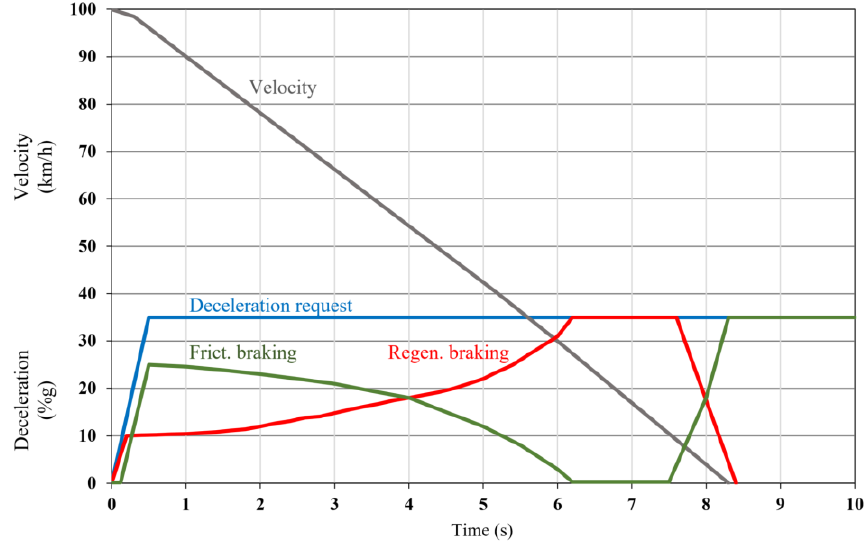
Figure 2. Regenerative braking and brake blending according to [1].